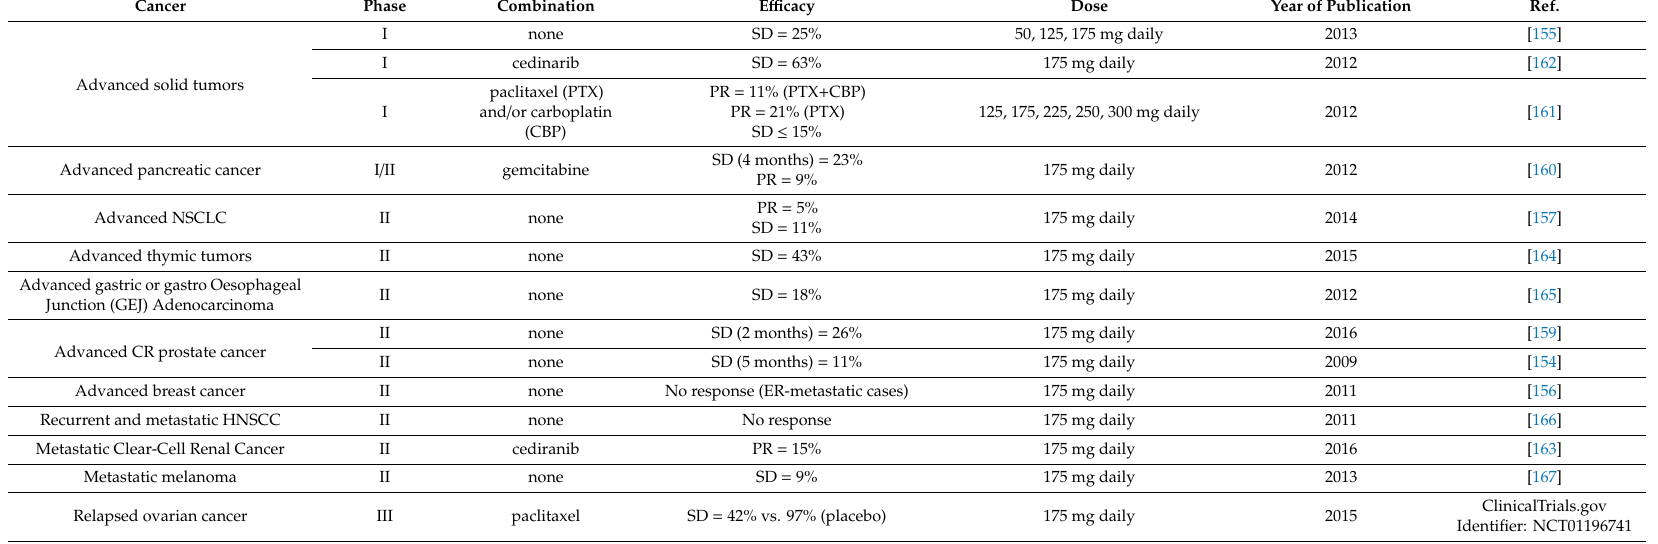
Table 3. Main characteristics of clinical trials designed in advanced solid tumors for the treatment with saracatinib alone or in combination with other drugs. E ffi cacy is to be considered as best clinical response, and when available, the population with the best response is indicated. PR = partial response; SD = stable